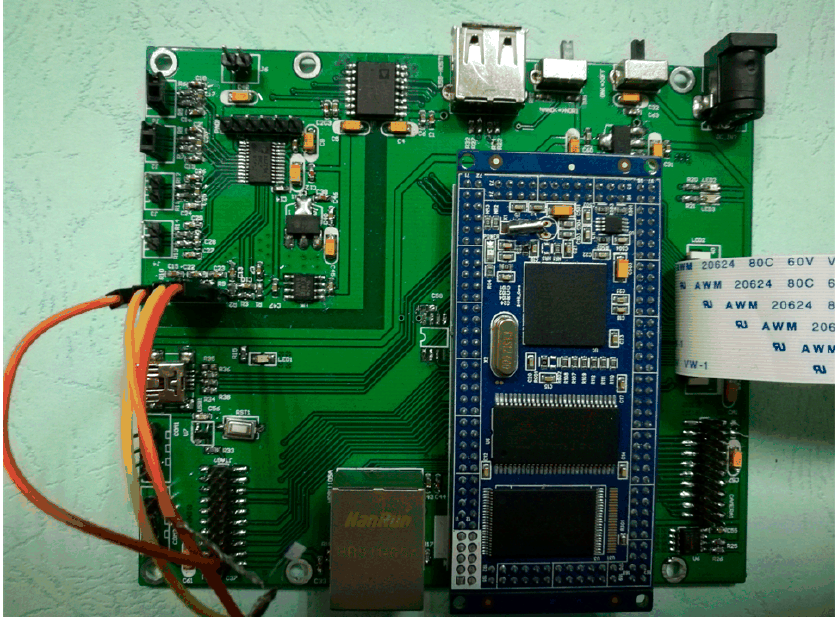
Figure 12. Photograph of the designed hardware circuit system of the array-type MEMS intelligent pressure sensor system.